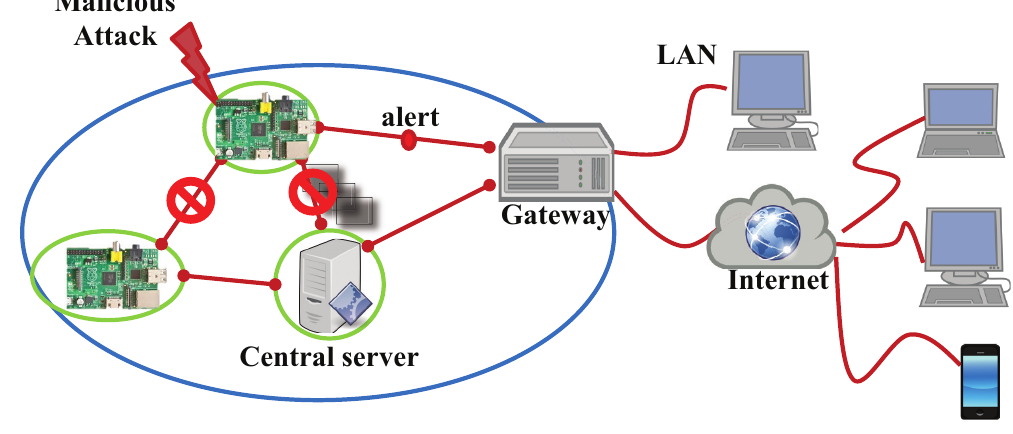
Figure 8. IoT network consisting of smart physical objects.